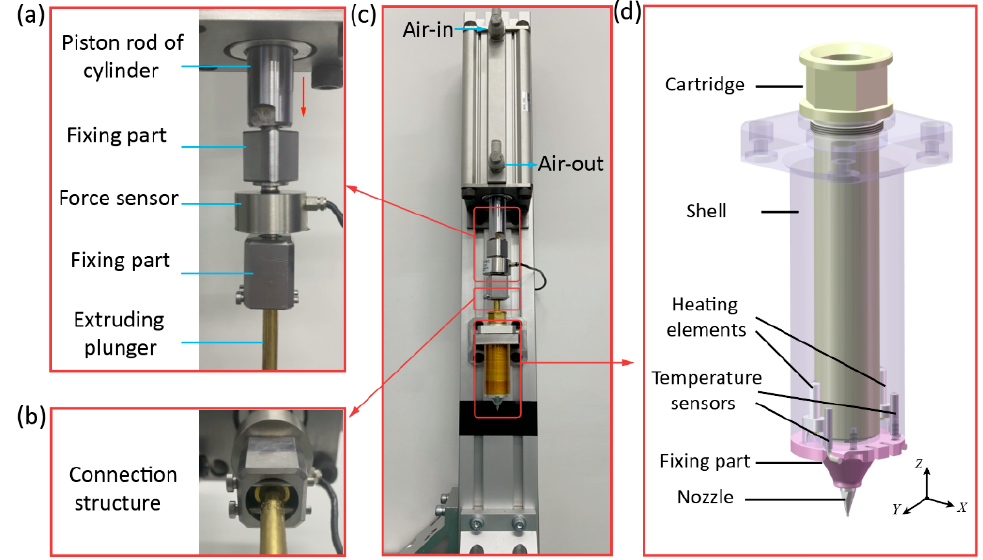
Figure 1. The configuration of a self-designed extrusion 3D printing device. ( a ) The enlarged view of the force sensor; ( b ) The connection structure; ( c ) The self-designed 3D print device; ( d ) The homemade print head.